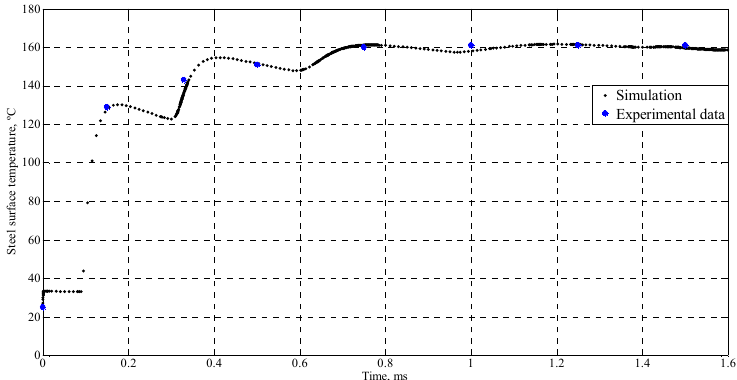
Figure 8. Comparison between experimental and simulated data for the steel temperature at the tin drop center.